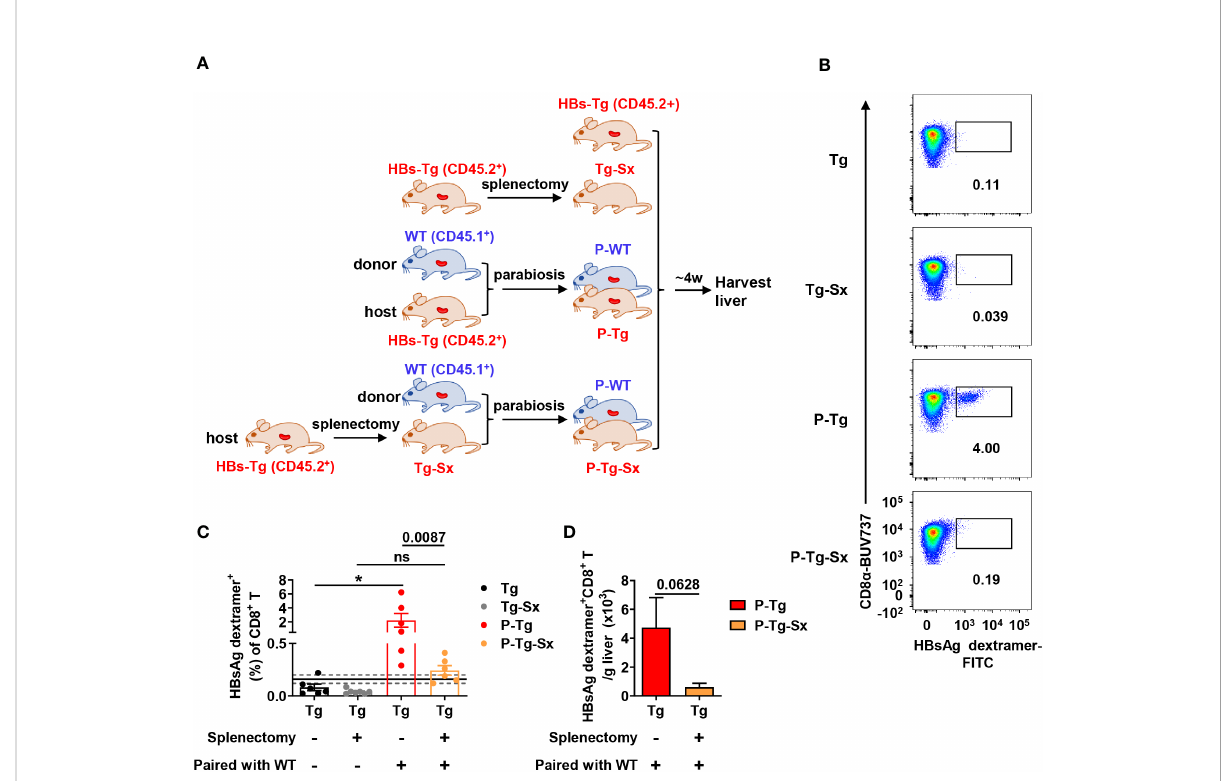
FIGURE 5 Donor HBsAg-speci fi c CD8 + T cells could not be effectively generated in the splenectomized-HBs-Tg parabionts paired with WT mice. HBs-Tg mice (CD45.2 + ) were performed splenectomy, then were surgically conjoined with WT mice (CD45.1 + ) to generate WT-HBs-Tg-Sx parabiotic mice. Four weeks after surgery, parabiotic mice were separated and liver samples were harvested from each group. Intrahepatic MNCs were isolated for fl ow cytometry analysis. (A) Protocol for the model of WT-HBs-Tg-Sx parabiotic mice and WT-HBs-Tg parabiotic mice (schematic). (B) Representative plots showing the frequency of HBsAg dextramer + CD8 + T cells in the liver of each group. (C) The frequency of HBsAg dextramer + CD8 + T cells in the liver of P-Tg-Sx (splenectomized-HBs-Tg paired with WT), compared with P-Tg (HBs-Tg paired with WT), Tg (HBs-Tg control) and Tg-Sx (splenectomized-HBs-Tg control). The data ranging in 95% con fi dence interval (CI) (0.16% ± 0.04%, as described in Figure 3B) were considered negative. A Fisher ’ s exact test was used to compare the positive rate of MHC dextramer staining in P-Tg and P-Tg- Sx groups with the corresponding control group respectively. The Mann-Whitney test was used to compare the frequency of HBsAg dextramer + CD8 + T cells between P-Tg and P-Tg-Sx groups. (D) The number of HBsAg dextramer + CD8 + T cells in the liver of P-Tg and P-Tg-Sx. The Mann-Whitney test was used. Data are shown as mean ± SEM. The numbers between the bars show the p-values. * P < 0.05; ns, not signi fi cant. Tg, HBs-Tg control; P-WT, WT parabiont; P-Tg, HBs-Tg parabiont; Sx,